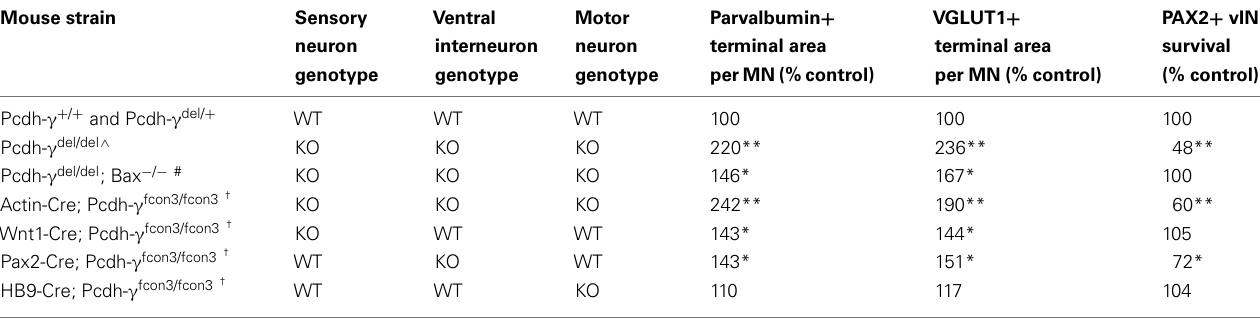
Table 1 | Summary of phenotypes in the various Pcdh- γ mouse strains examined.